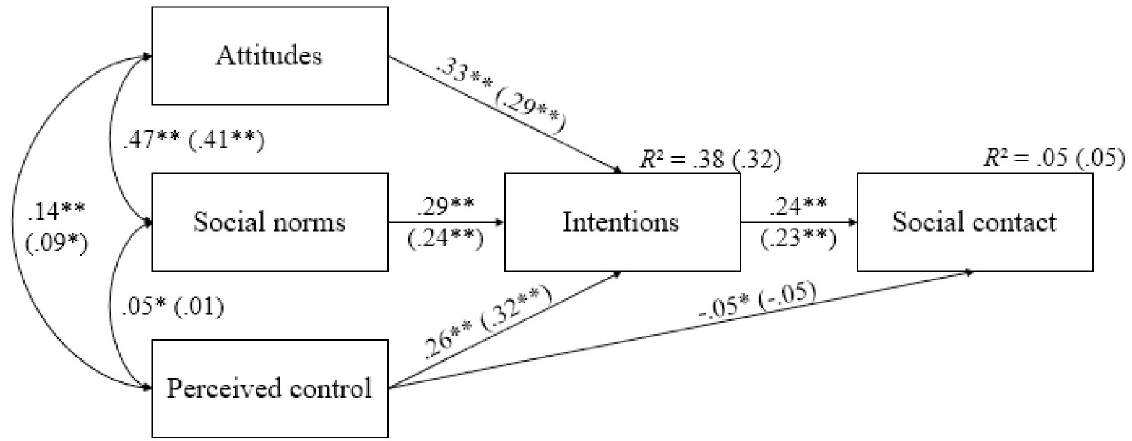
Fig 5. Standardized path coefficients for Belgian and French (in parentheses) residents for limitation of social contacts ( N = 3744). � p < .01. �� p < .001. R 2 = R-squared.